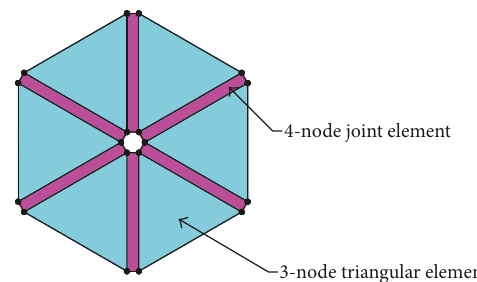
Figure 1: Discretized intact body with 3-node triangular elements and 4-node joint